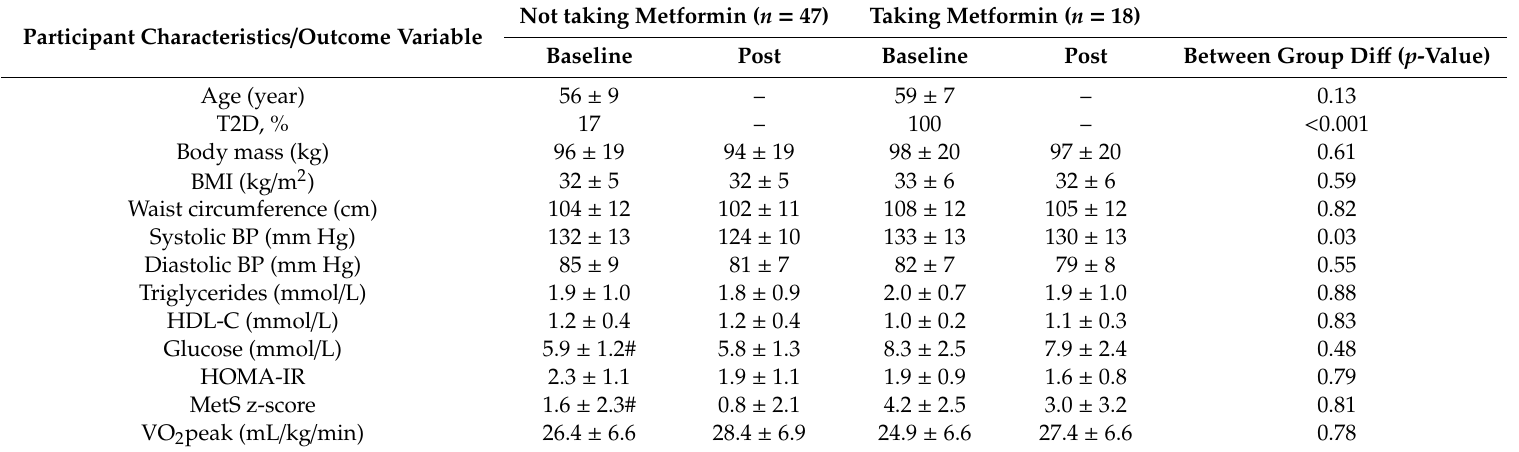
Table 1. Participant characteristics of those not taking or taking metformin.